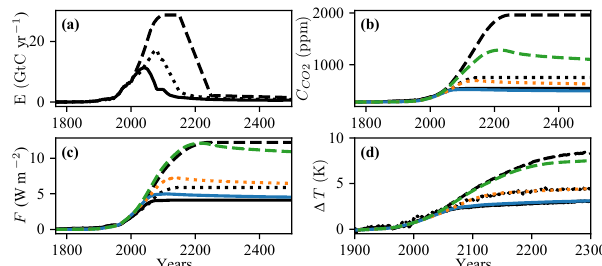
Figure 2. Reconstruction of RCP results using the response func- tion model. In all panels, solid lines refer to RCP4.5, dotted to RCP6.0 and dashed lines to RCP8.5. Black lines show RCP data while colors (blue: RCP4.5, orange: RCP6.0, green: RCP8.5) give our reconstruction. (a) Fossil CO 2 emissions. (b) CO 2 concentra- . (c) Total anthro- tions from RCP and reconstructed using G CO 2 pogenic radiative forcing (black) and radiative forcing from CO 2 only (red) (both from RCP) and reconstructed forcing using the re- lations above. (d) Temperature perturbation from CMIP5 RCP (en- semble mean) and the our